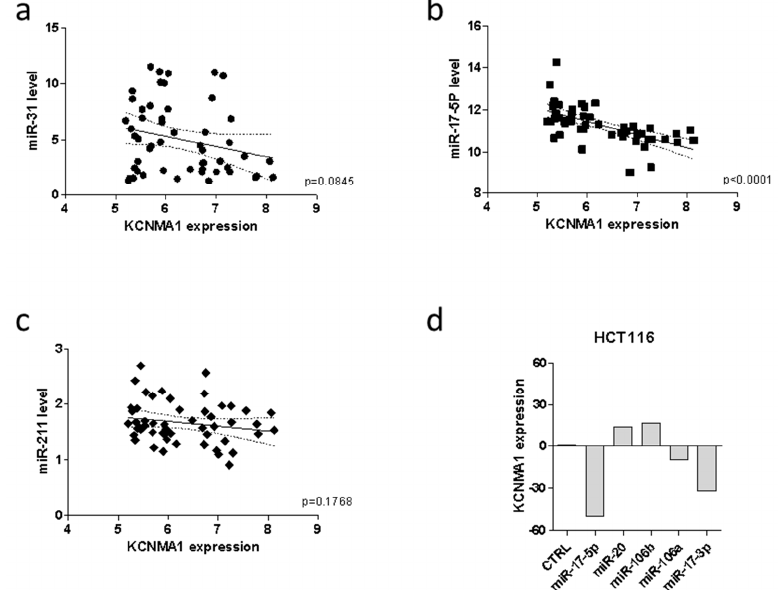
Figure 5. MiRNAs regulating KCNMA1 expression. Correlation between KCNMA1 expression levels and miR-31 ( a ), miR-17-5p ( b ), and miR-211 ( c ) in CRC patients ( n = 31), as determined in the GSE35834 dataset; ( d